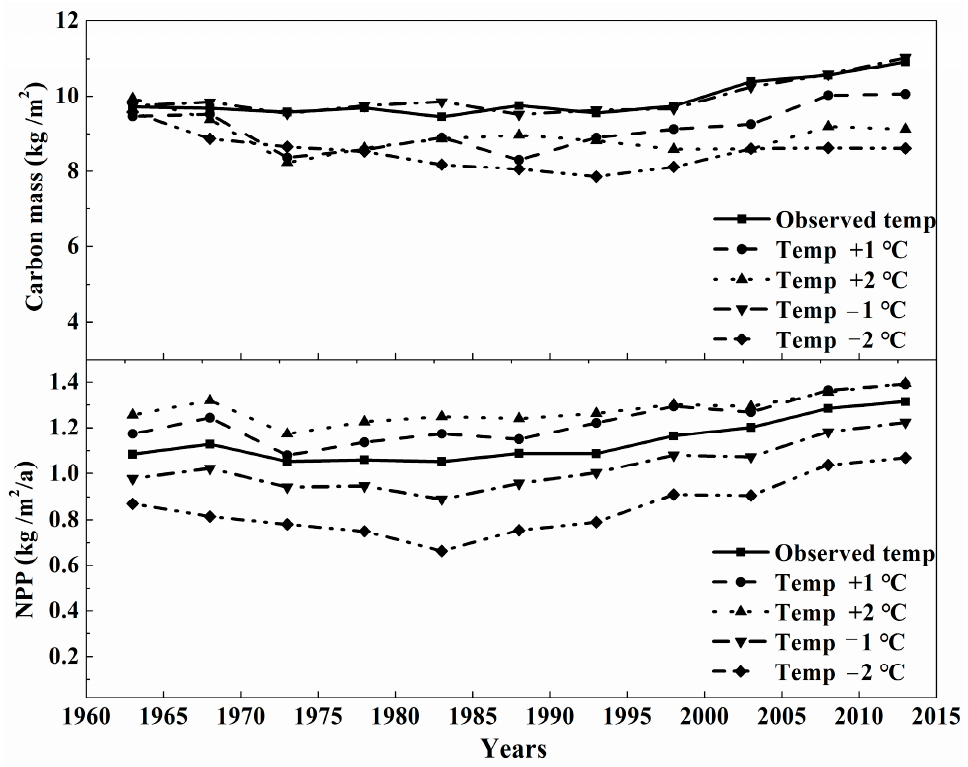
Figure 4. LPJ-GUESS output showing the effects on stored carbon (top panel) and NPP (bottom panel) of changing the temperature only. Temperature was modified by adding or subtracting 1 (or 2) °C to each daily climate value. Lines represent the means of the simulations. Temp: the abbreviation of temperature.